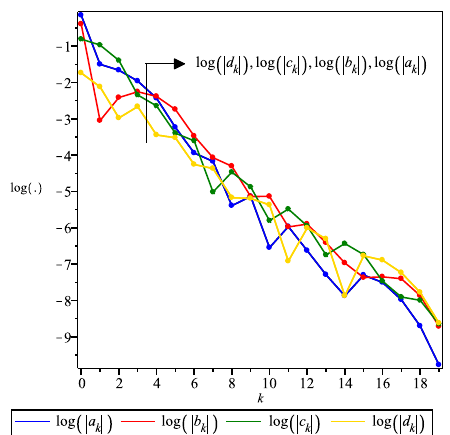
Figure 10. Logarithmic graphs of absolute coefficients | a k | , | b k | , | c k | and | d k | of the rational Gegenbauer functions when N = 0.8, K = 0.2 and Sc =